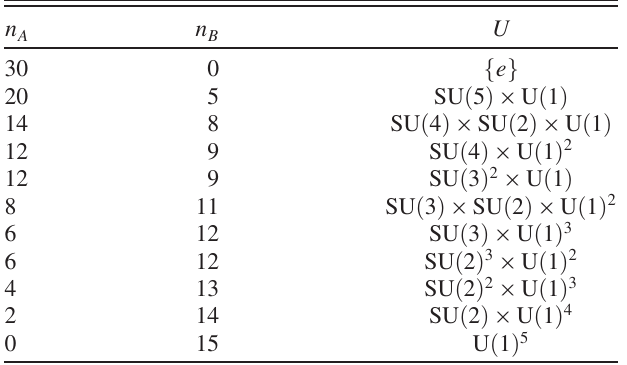
TABLE III. Possible number of type- A and type- B NGBs